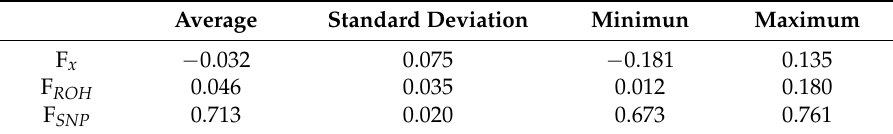
Table 4. Estimated levels of inbreeding.